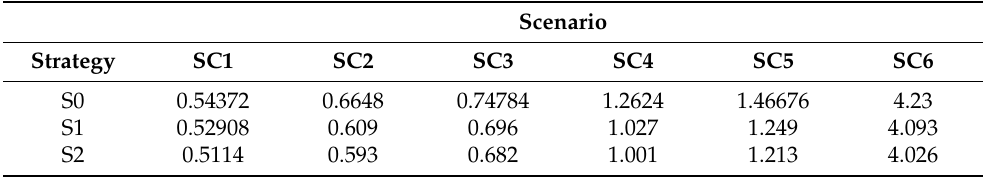
Table 3. Total fuel consumption ( Fuel T ( liter ) under 2.4 s cycle) under different scenarios and PF-based strategies used to test the performance of the PV/FC/ESS